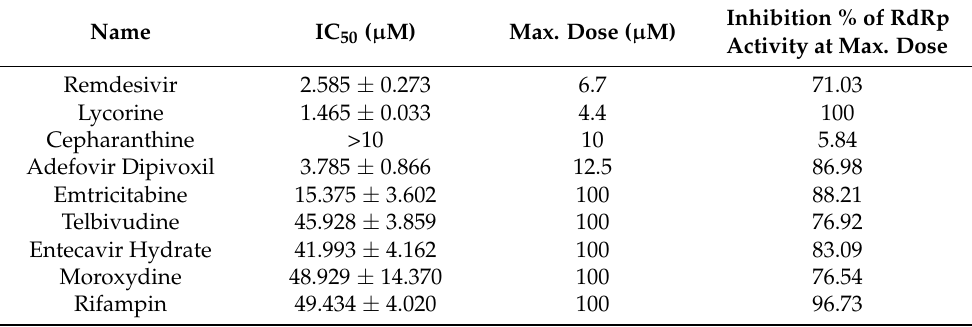
Table 1. IC 50 and inhibition percentage of SARS-CoV-2 RNA-dependent RNA polymerase (RdRp) ac- tivity at the maximum concentrations. It was representative of at least three independent experiments. The data were presented as mean ± standard error of the